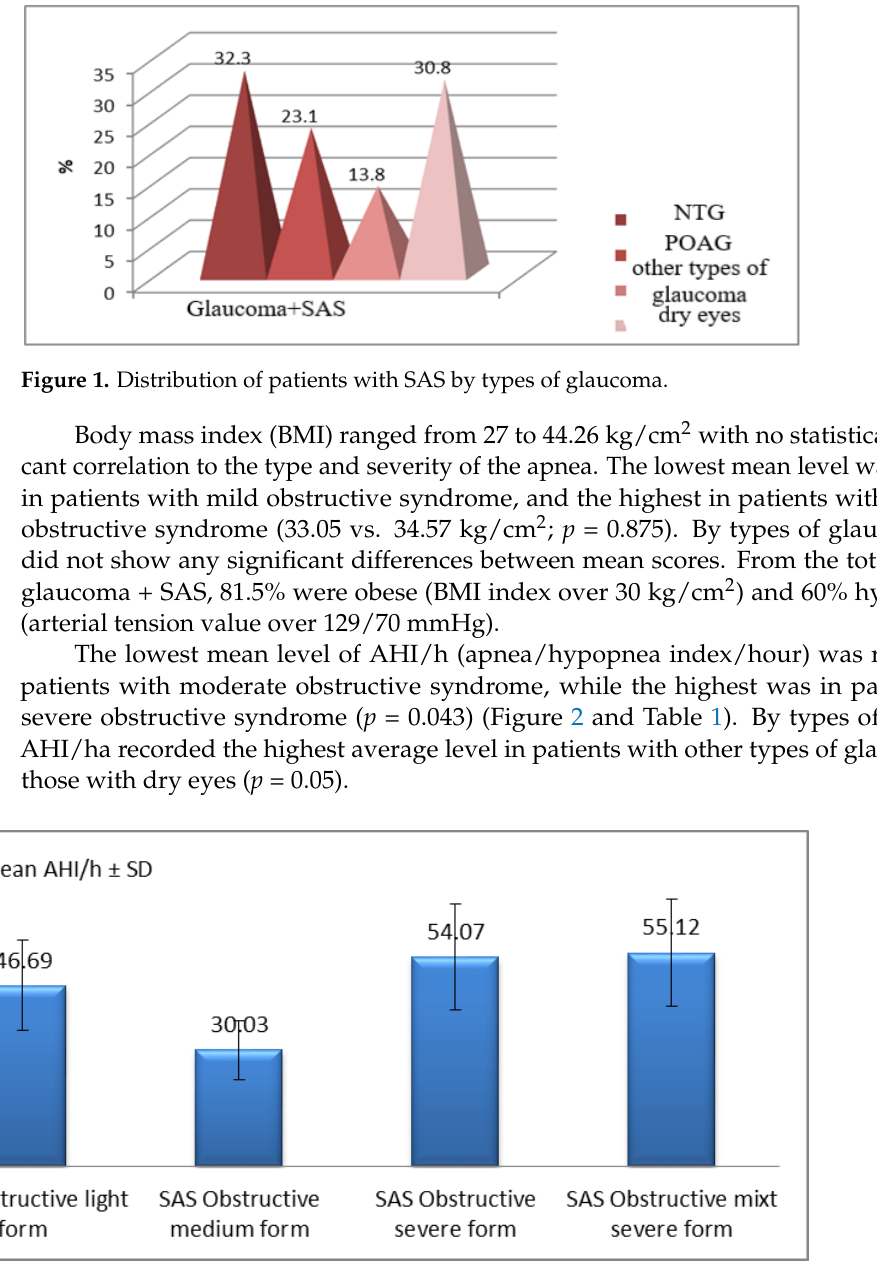
Figure 1. Distribution of patients with SAS by types of glaucoma.